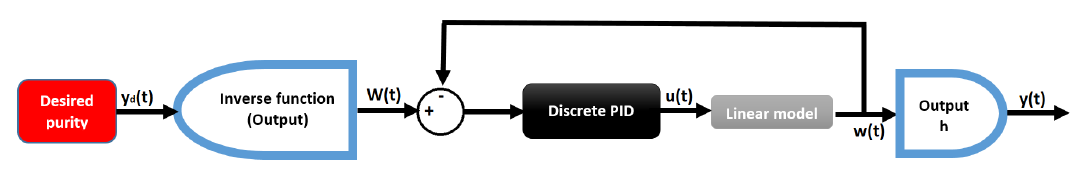
Figure 11. Discrete PID control implementation on the Hammerstein–Wiener model.